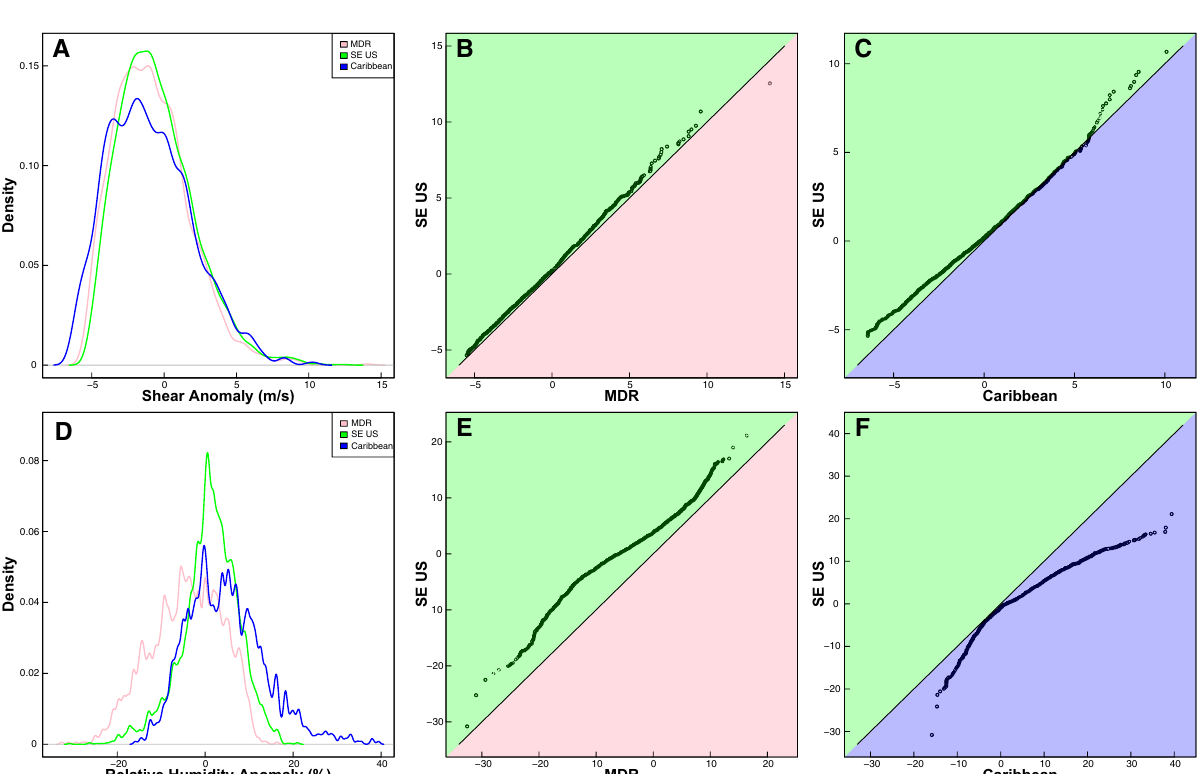
Figure 5. Probability density functions of vertical wind shear ( A ) and relative humidity ( D ) anomalies across regions for each genesis point in the future era relative to the 1980–2000 baseline. Note, the baseline is defined as the 1980–2000 mean of ( A ) wind shear and ( D ) relative humidity values across the full season for each individual region. In figures ( A ) and ( D ), lines represent the MDR (pink), SE US (green), and Caribbean (blue) regions. QQ-plots ( B , C , E , F ) compare the quantiles of the distributions of the wind shear ( B , C ) and relative humidity ( E , F ) anomalies between the MDR and SE US ( B , E ) and between the SE US and Caribbean ( C , F ). Background colors on QQ-plots are the same as colors used for PDFs, and indicate different regions. Black solid lines on the QQ-plots show the 1–1 line; points that diverge from this line indicate that the distributions for the two regions being compared are significantly